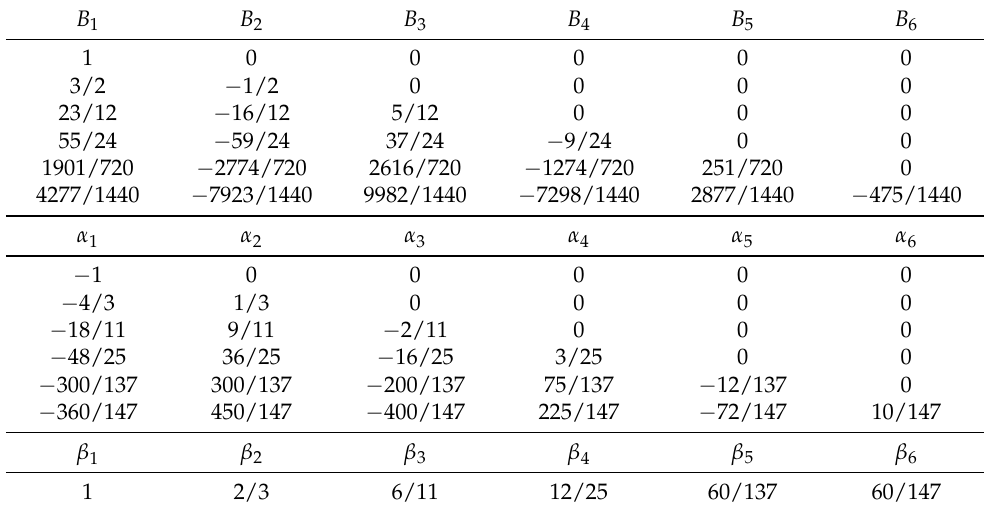
Table 1. Coefficients of the Adams–Bashforth–backward differentiation